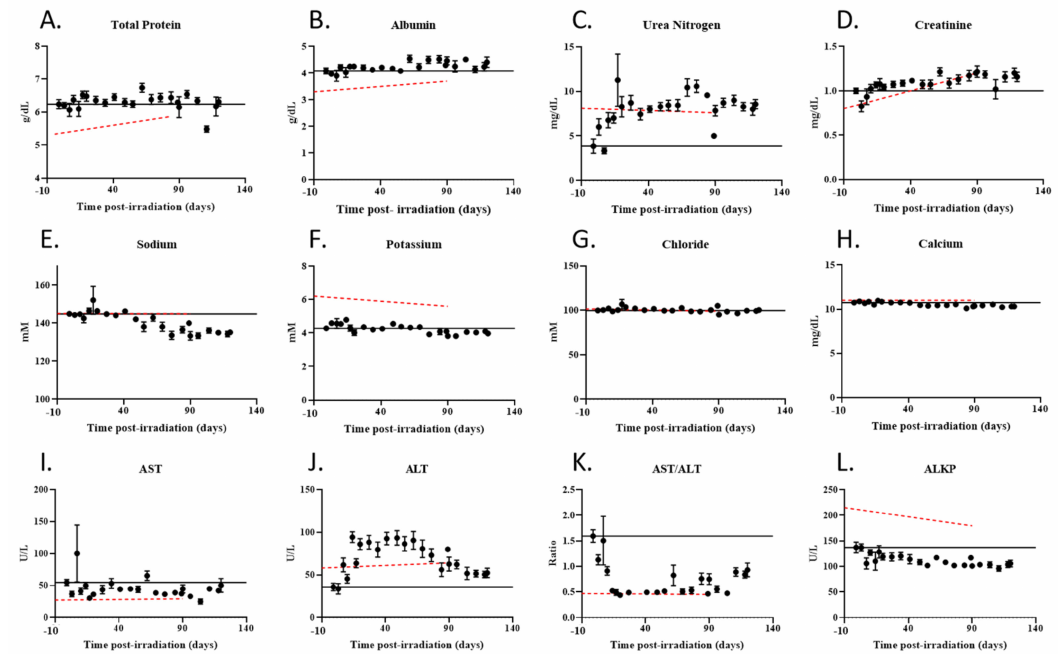
Figure 5. Longitudinal analysis of clinical chemistry parameters in the plasma of irradiated minipigs. ( A – L ) Reference values for each parameter were obtained from the vendor from non-irradiated, age-matched animals and are represented by the broken red line; the solid black line marks the pre-irradiation level of each parameter. Values are reported over time as averages +/ − sem.